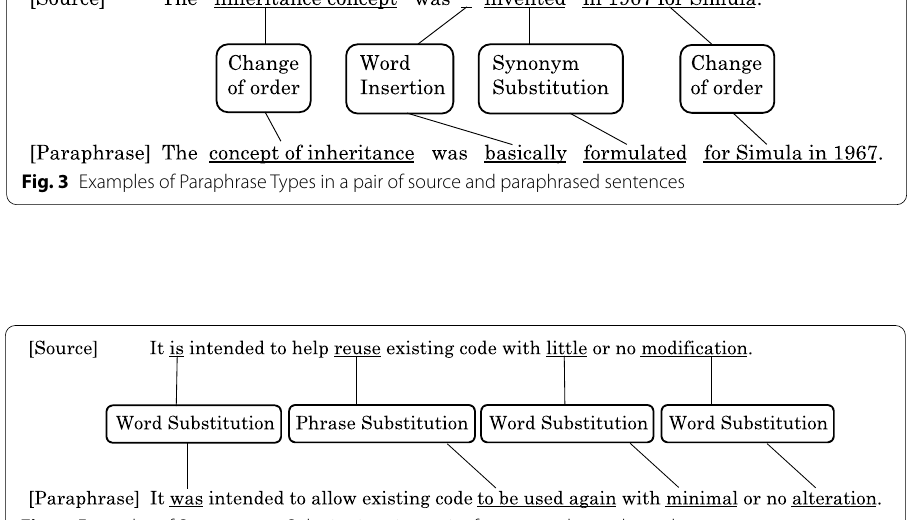
Fig. 4 Examples of Synonymous Substitutions in a pair of source and paraphrased